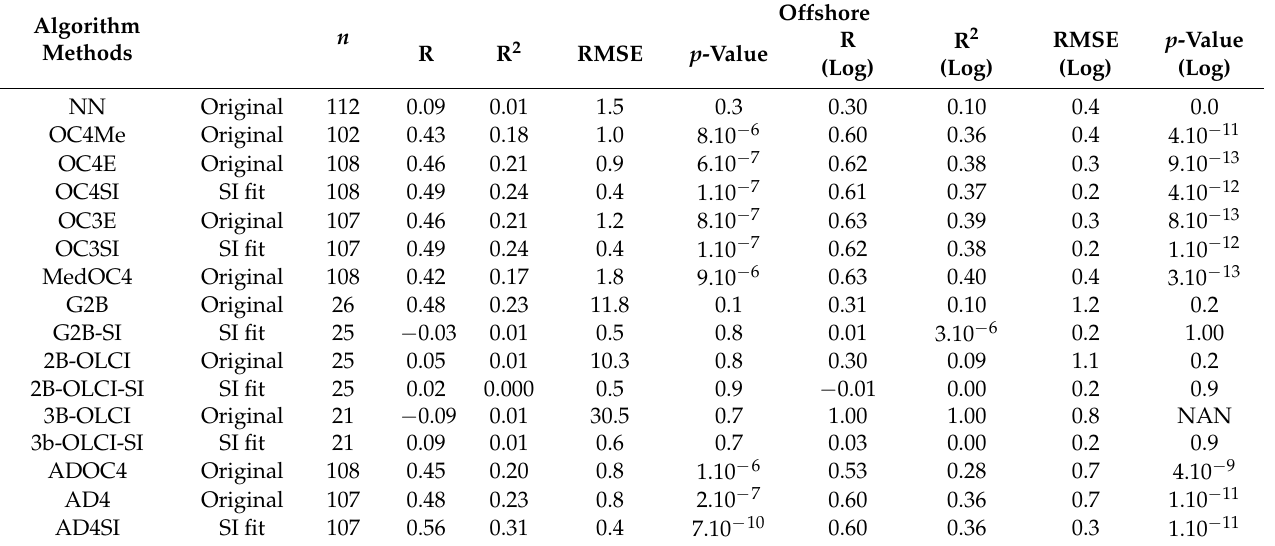
Table 3. Statistical analysis (R, R 2 , RMSE and p-value) for the original (OC4Me, NN, OC3E, OC4E, MedOC4, ADOC4, AD4, 3B-OLCI, 2B-OLCI and G2B) and recalibrated (OC4SI, OC3SI, AD4SI, G2B-SI, 2b-OLCI-SI, 3B-OLCI-S) Chl- a algorithms at offshore points.